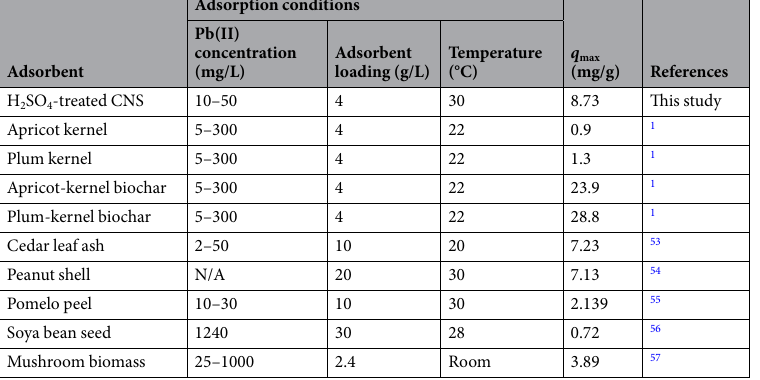
Table 4. Comparison of maximum adsorption capacity ( q max ) for Pb(II) of this study with previous